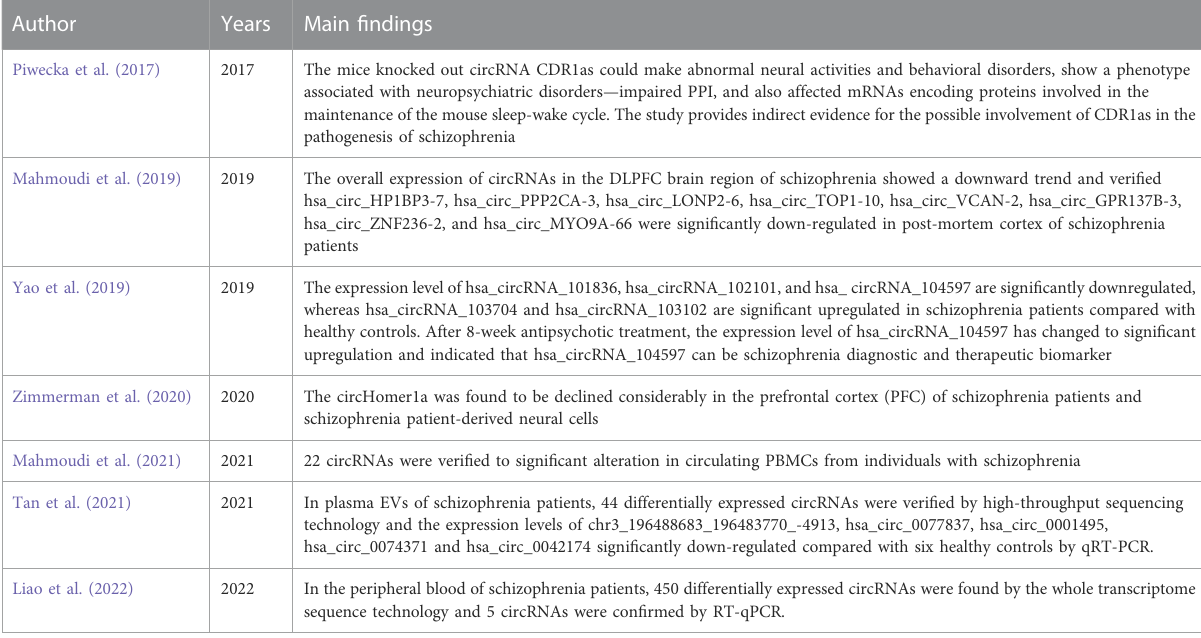
TABLE 1 The circRNAs abnormally expressed in different tissues of schizophrenic patients. Author